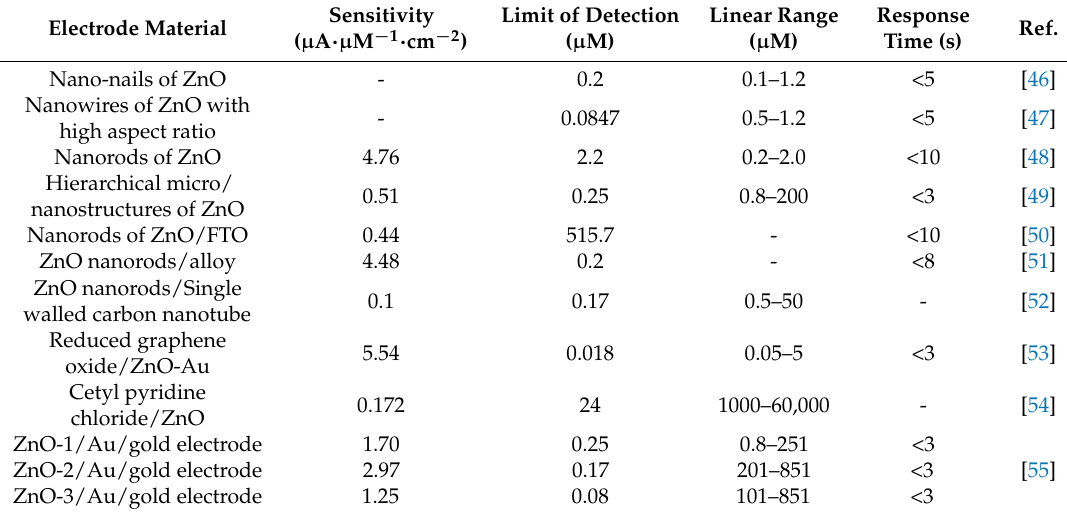
A response comparison of as-fabricated sensors in this work with various ZnO nanostructure-based hydrazine